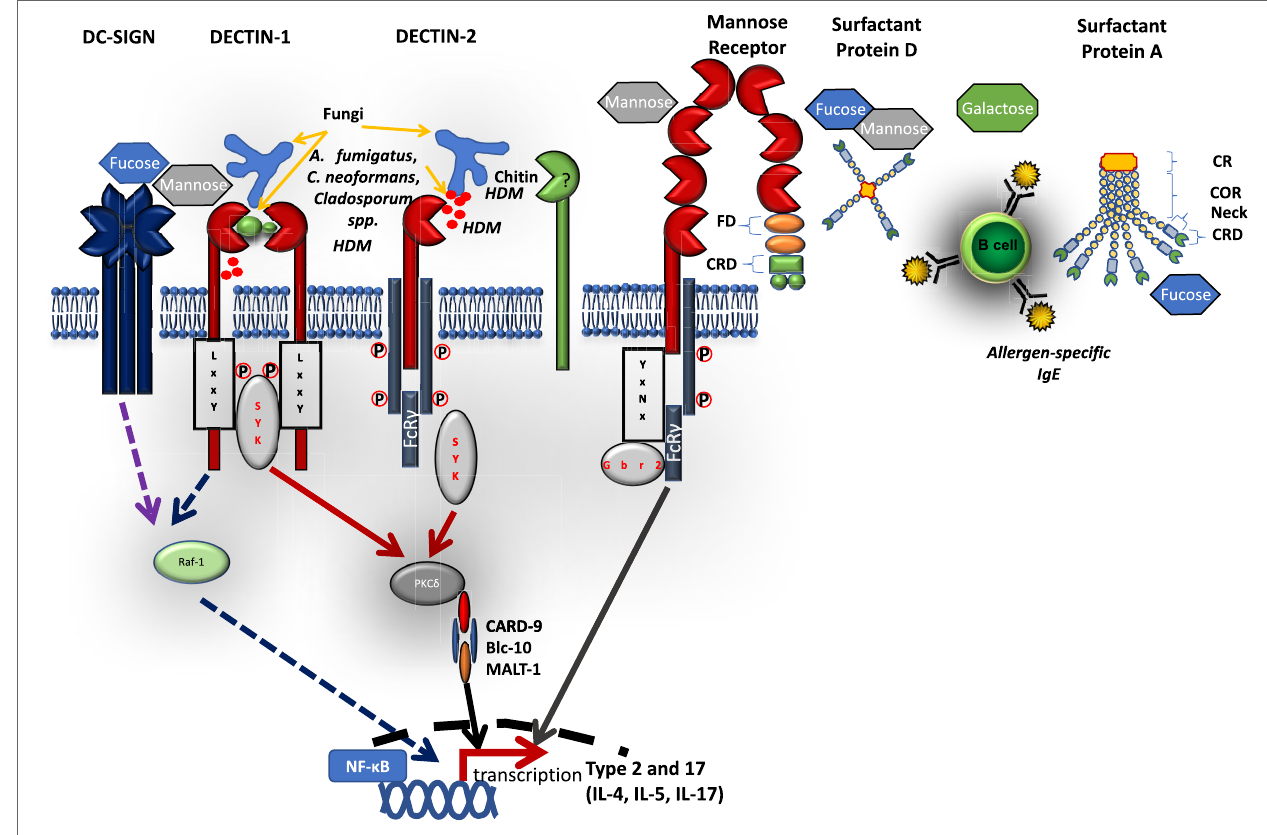
FigURe 1 | Schematic diagram of selected C-type lectin-like receptors (CLRs) and their respective ligands. C-type lectin receptors bind to their respective extracellular microbial pattern-associated molecular patterns on cell wall surfaces of fungi and house dust mites. Most CLRs signal via a Syk-dependent pathway inducing reactive oxygen species, inflammatory cytokines, and antimicrobial peptides. Some CLRs, e.g., dectin-1 and DC-specific intercellular adhesion molecule 3-grabbing nonintegrin can signal via a Syk-independent pathway involving Raf-1. Some CLRs (such as dectin-2 and MR) cannot directly activate Syk, but require adaptor protein FcR γ attached to its intracellular immunoreceptor tyrosine-based activation motifs. Soluble CLRs, such as surfactant proteins (SP-A, SP-D) are arranged in either one or two polypeptide chains with a CRD connected to neck region, a collagen-rich domain, and cytoplasmic region. FD, fibronectin domain; CRD, carbohydrate recognition domain; COR, collagen-rich domain.